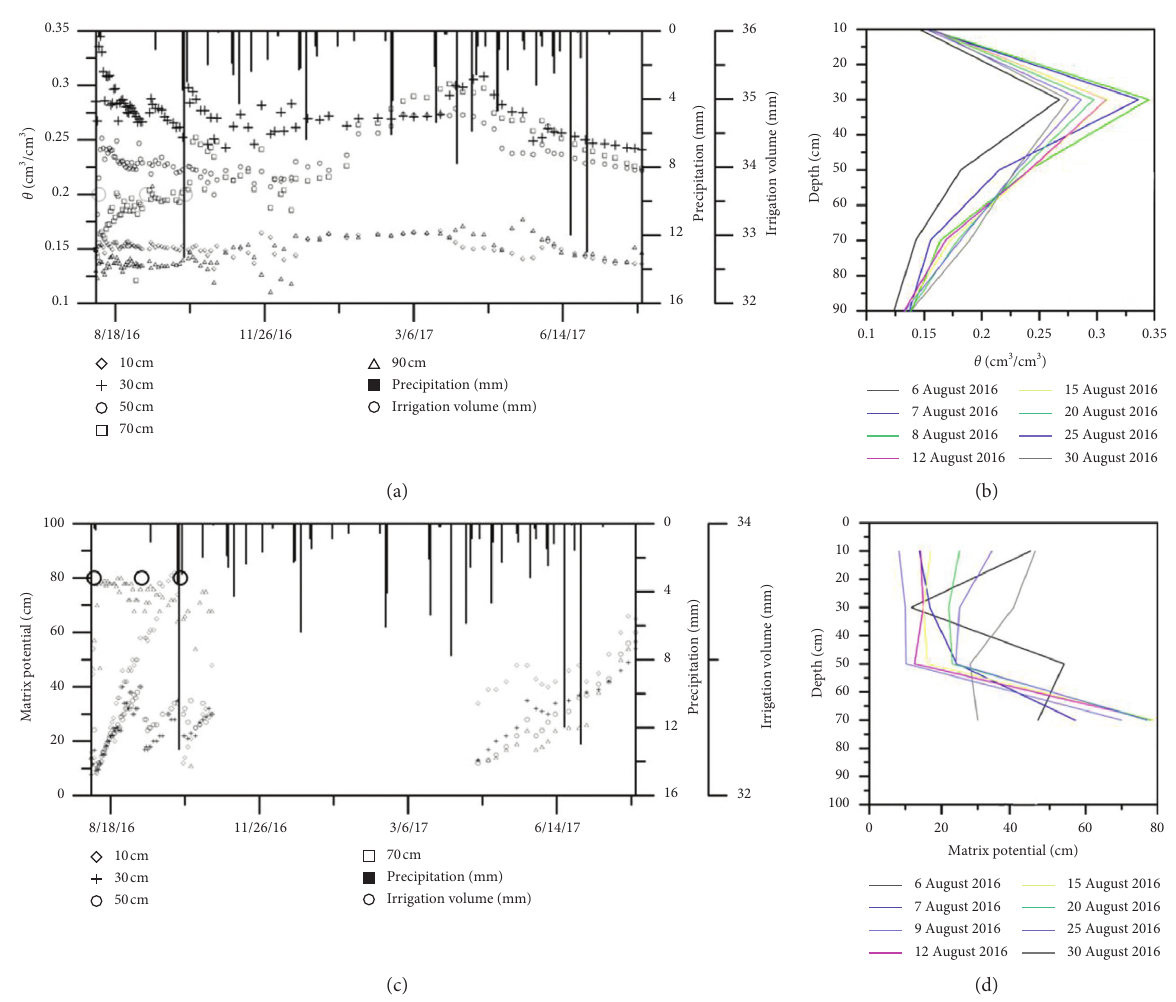
Figure 10: Water distribution in soil with a thickness of 70cm with compaction once: (a) water distribution at different depths; (b) response of water content to irrigation; (c) matrix potential at different depths; (d) response of matrix potential to